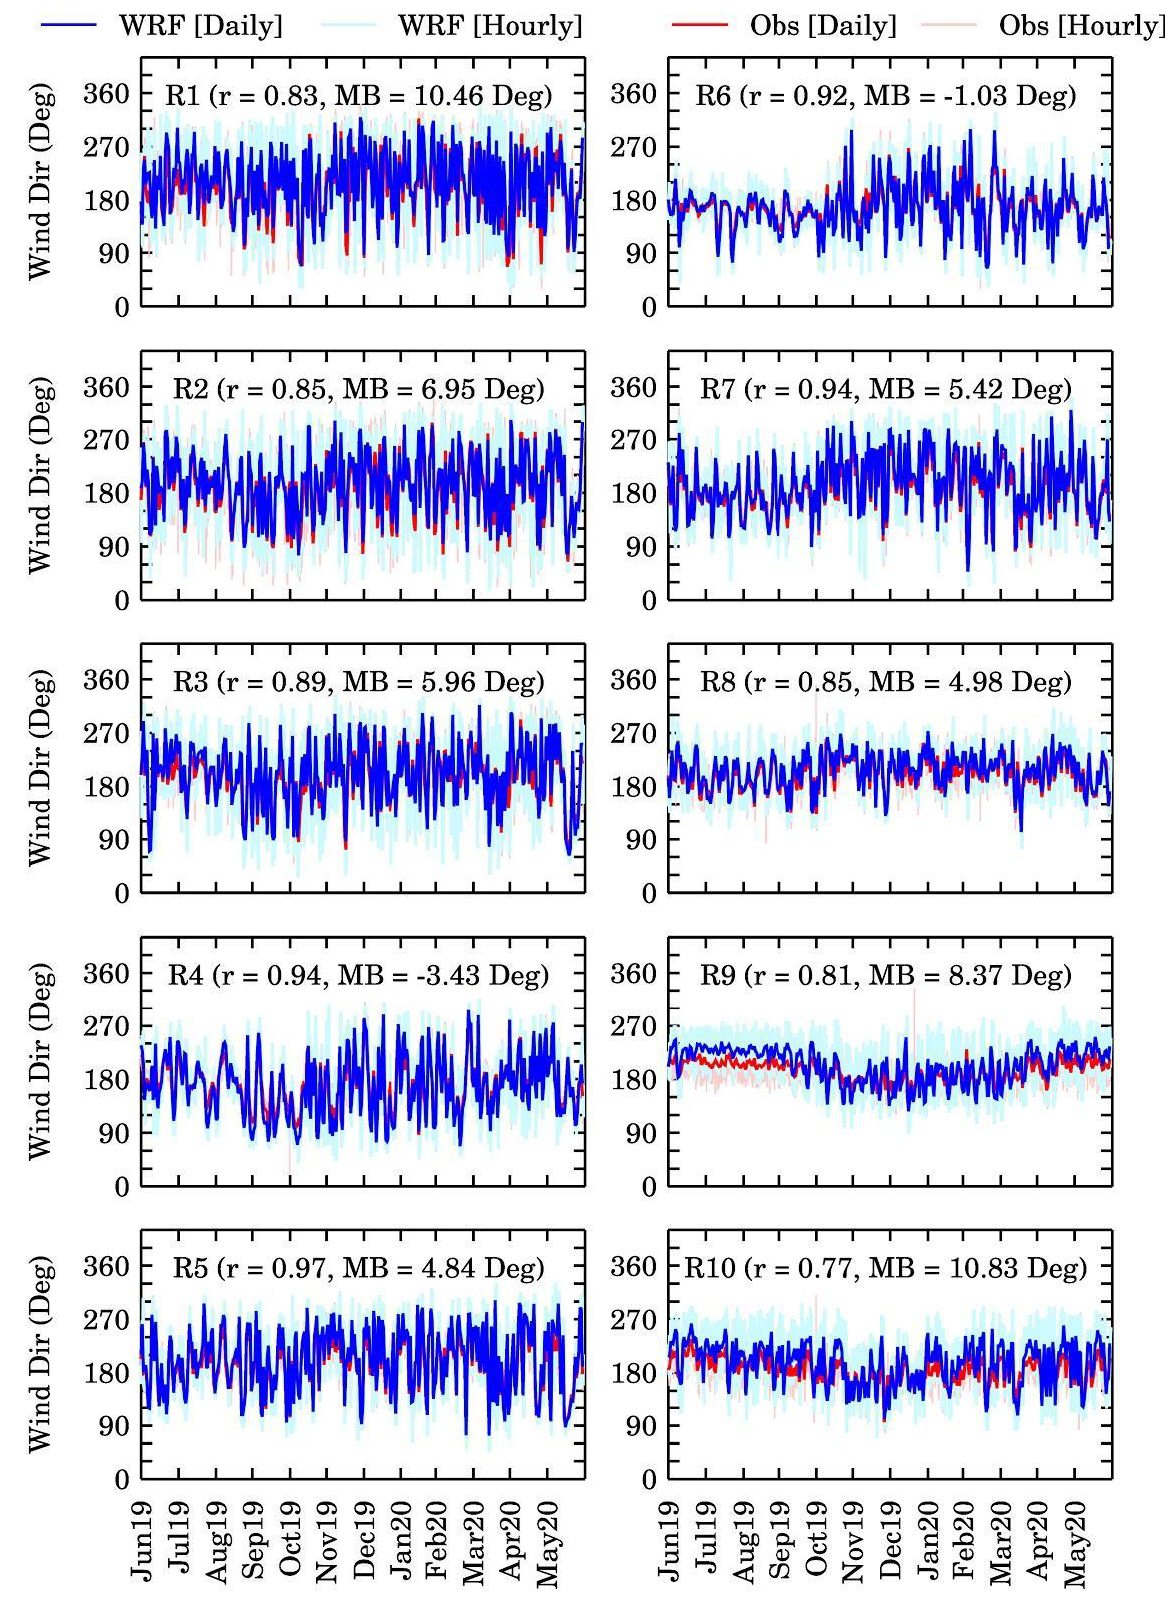
Figure 9. Seasonal variations in hourly and daily observed and model-simulated 10 m wind direction in 10 EPA regions during June 2019 to May 2020. r and MB for each region estimated using paired data for the full year are also shown.